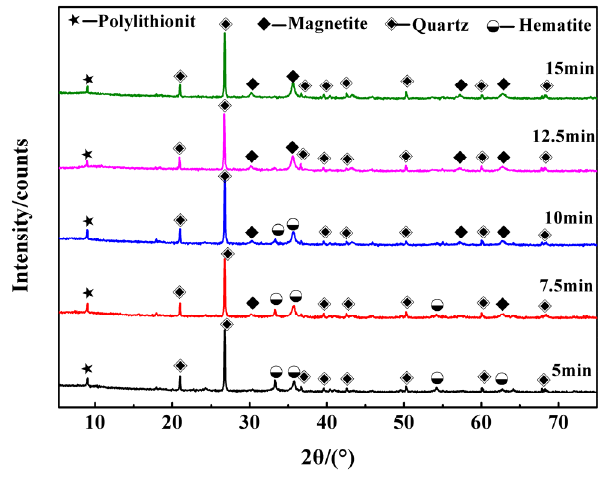
Figure 6. XRD analysis of roasted samples at different roasting times.